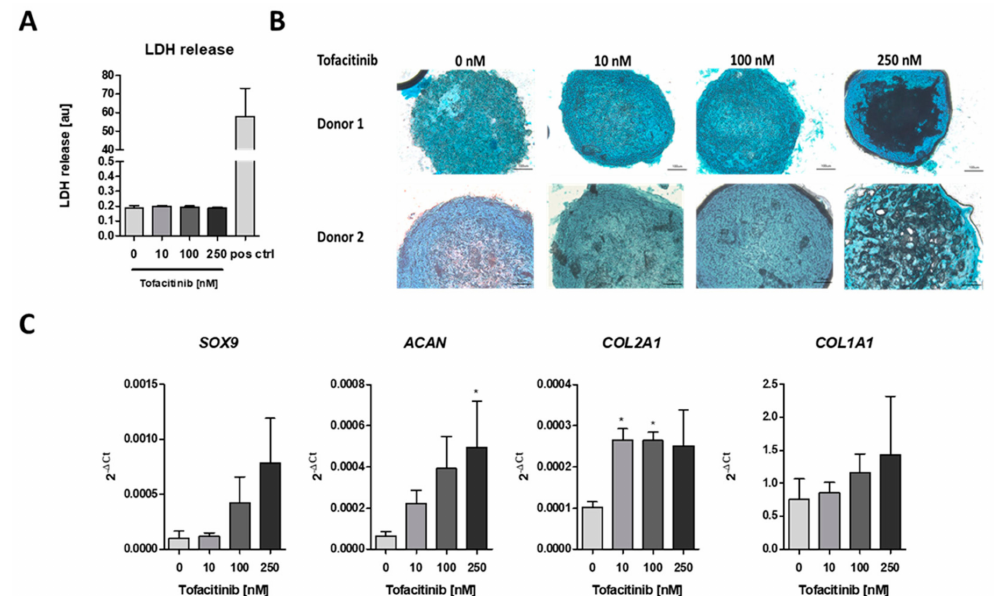
Figure 2. Tofacitinib did not inhibit survival and chondrogenic di ff erentiation at therapeutic relevant doses of 10–100 nM. ( A ) LDH release was determined after 3 weeks of chondrogenic di ff erentiation ( n = 3; one-way ANOVA with Bonferroni post hoc test). ( B ) Alcian blue stainings of slices from cryo-preserved micro-mass cultures of chondrogenic di ff erentiated hMSCs (2 of 4 donors, scale bars = 100 µ m) ( C ) Chondrogenic marker gene expression for SOX9, ACAN, COL2A1 as well as osteogenic marker COL1A1 after 1 week of di ff erentiation ( n = 3; * p < 0.05; 1way ANOVA with Dunn’s multiple comparison post hoc test; asterisks above columns indicate comparison to the respective untreated control = 0 nM